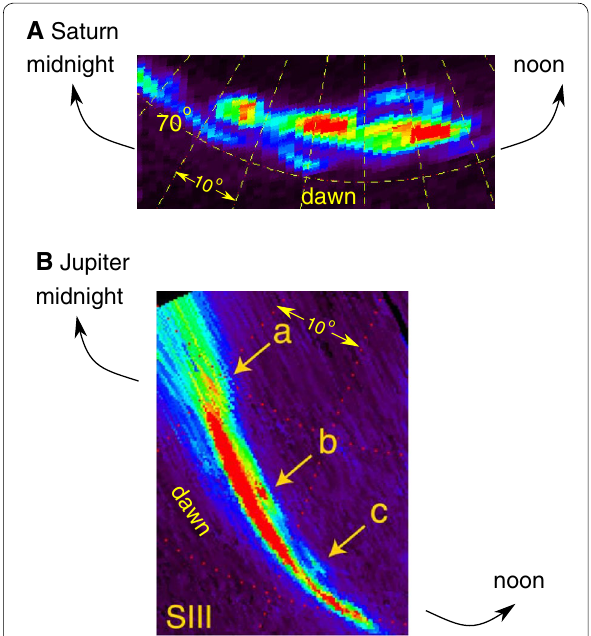
Fig. 4 A The auroral image of Saturn’s polar region from Cassini UVIS at 21:49 UT on May 20, 2013, adopted from Radioti et al. (2016). B The auroral image of Jupiter’s polar region from HST at 05:37 on March 5, 2007 (Adopted from Radioti et al.